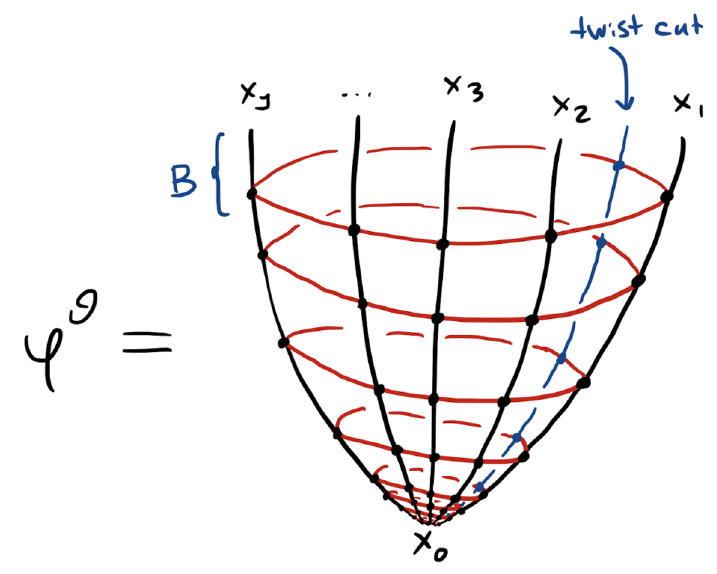
Figure 2 . Feynman graphs contributing to the CFT wave function has an iterate structure. The blue line crossing propagators indicates that these propagators are twisted with the global symmetry G